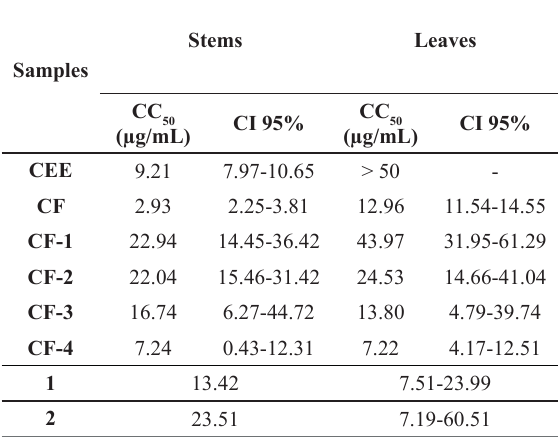
Antiproliferative activity against A549 cells of Aristolochia triangularis extracts, fractions and compounds 1 and